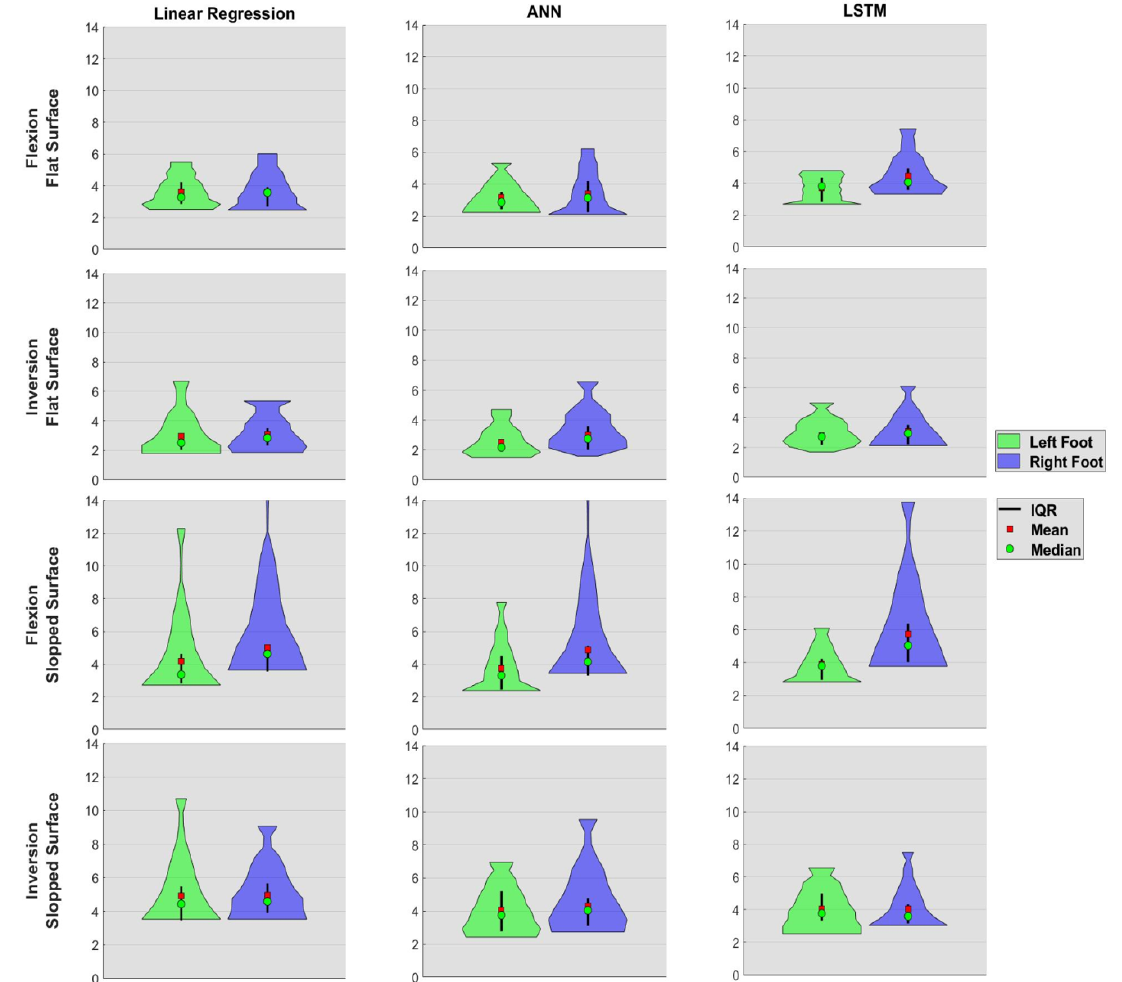
Figure 6. Violin plot of RMSE measurements representing the kernel density distribution and mean, median and IQR (difference between 75th and 25th percentiles).